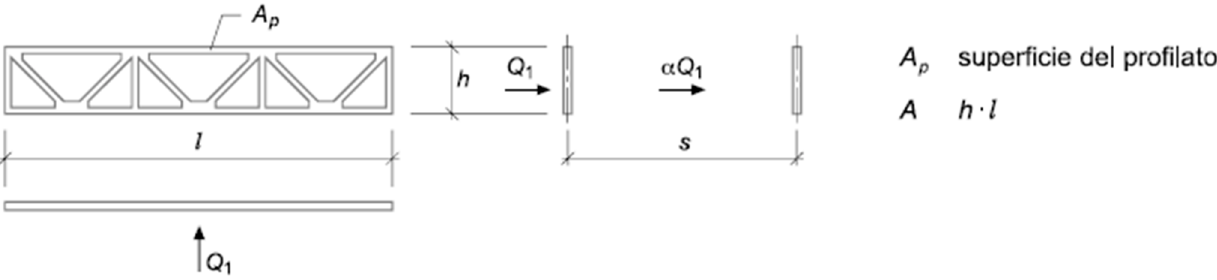
Figure 18. Force application method [8].